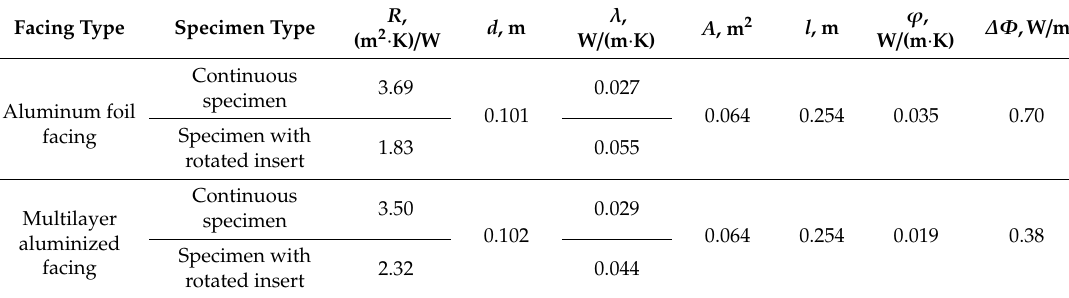
Table 3. Results of the experimental